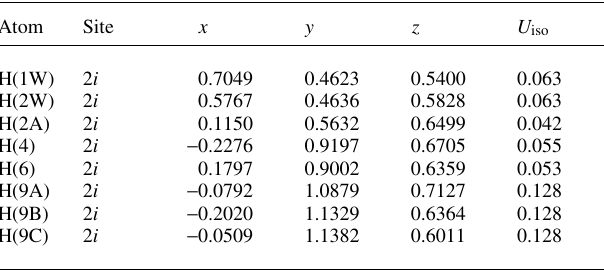
Table 2. Atomic coordinates and displacement parameters (in Å 2 )